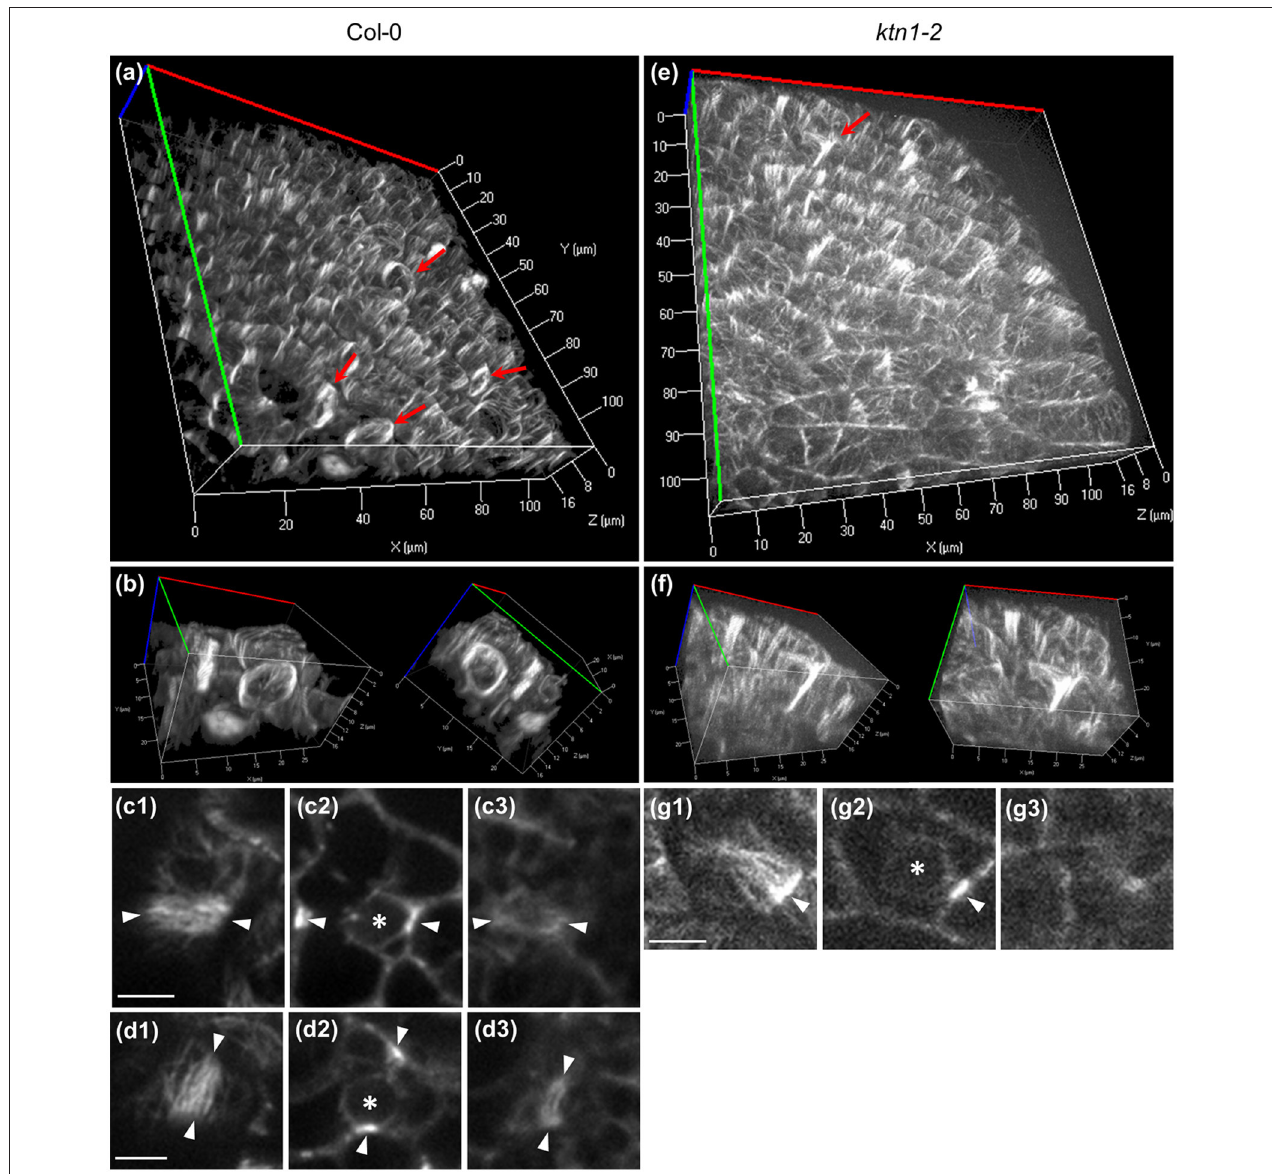
FIGURE 6 | Completeness of Col-0 and ktn1-2 PPB in the three dimensions as visualized in cotyledon epidermal cells expressing a GFP-TUA6 microtubule marker after Z-optical sectioning and 3D reconstruction (a,b,e,f) or after single optical section imaging (c,d,g) using spinning disc microscopy. (a,b) Overview (a) and higher magnification (b) of Col-0 cotyledon epidermis showing two adjacent cells with well-organized and complete PPBs at two different rotation angles. These cells are shown in a rotating panoramic view at Video S2 . (c,d) Top (c1,d1) , middle (c2,d2) , and bottom (c3,d3) views of the PPBs shown in (b) . (e,f) Overview (e) and detail (f) of aberrant PPB formation in ktn1-2 mutant at two different rotation angles. The same cell is shown in a rotating panoramic view at Video S3 . (g) Top (g1) , middle (g2) , and bottom (g3) views of the ktn1-2 PPB shown in (f) . Red arrows in (a,e) denote PPBs. Asterisks in (c2,d2,g2) denote nuclear position. Arrowheads in (c,d,g) denote the PPBs. For all Z-acquisitions shown herein, total scanning time was between 45s (a–d3) to 75s (e–g3) . Scale bars: 5 µ